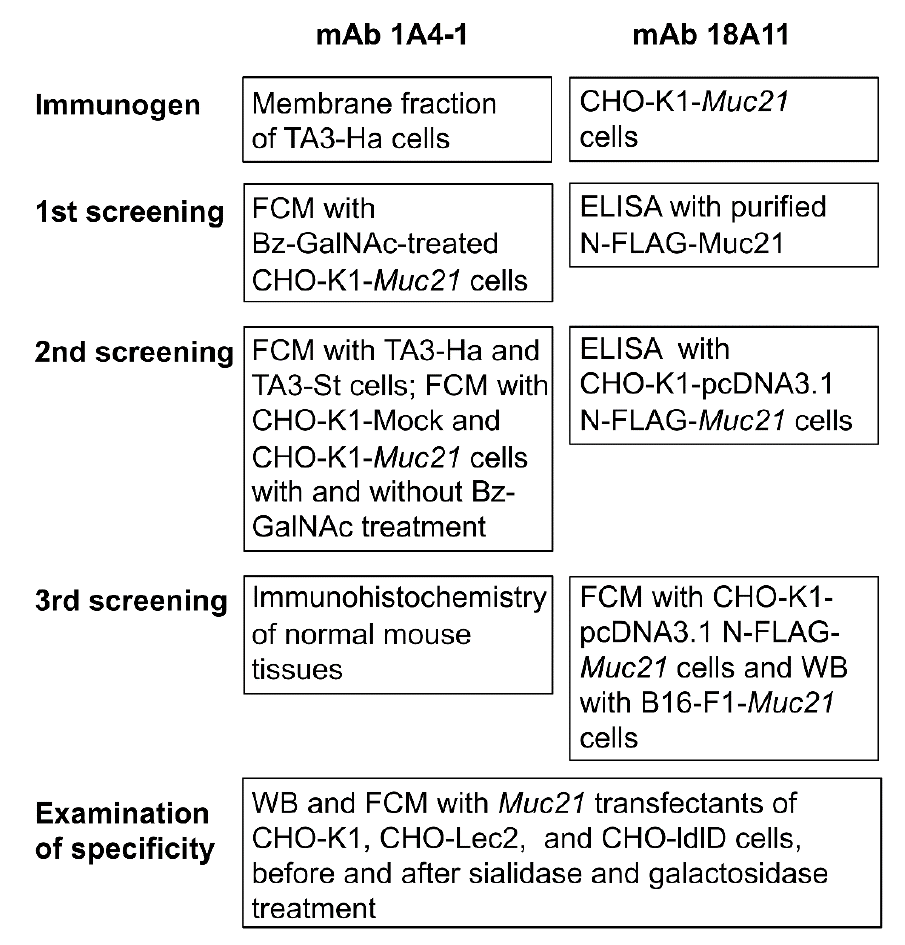
Figure 1. Strategy to obtain monoclonal antibodies (mAbs) 1A4-1 and 18A11, which are specific to distinct glycoforms of Muc21. Bz-GalNAc; benzyl- N -acetylgalactosaminide, CHO; Chinese hamster ovary cells, FCM; flow cytometry, WB; Western